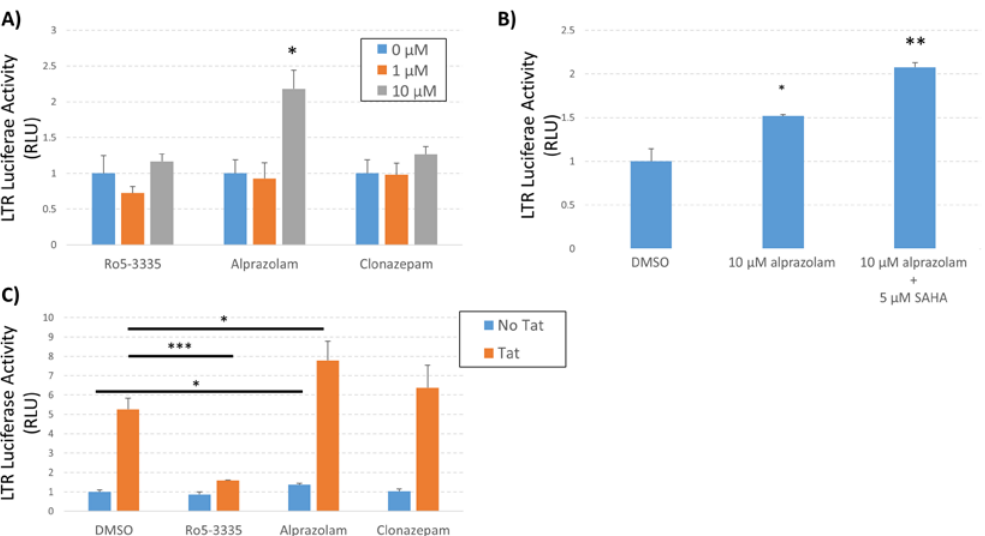
Figure 6. Effect of Alprazolam on HIV-1 transcription in TZMbl. TZMbl cells were seeded in 96-well plates and treated with ( A ) different concentrations of BDZs or ( B ) a combination of Alprazolam and SAHA. ( C ) TZMbl cells were transfected with pCMV-Tat or pUC19 control plasmid and treated with 10 µ M of the indicated BDZ. At 48 h after treatment, the cells were lysed and equal mass of protein lysates were used to determine the production of luciferase from the integrated LTR. Results are shown as the relative luciferase activity compared to control. Each data point is the average of three replicates. * P ≤ 0.05, ** P ≤ 0.04, *** P ≤